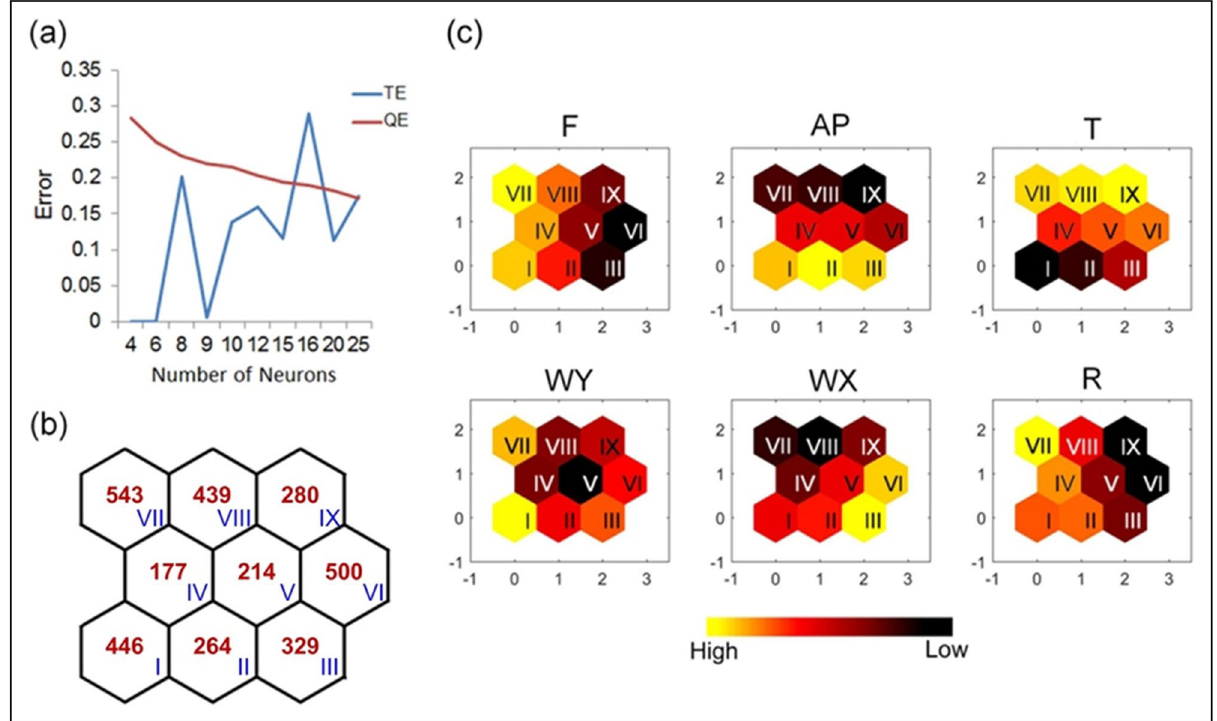
Figure 2. ( a ) Map size was determined to be 9 neurons (i.e., 3×3) based on the measurement of quantization error (QE) and topographic error (TE); ( b ) number of input records (shown in red) in each neuron (shown in blue); ( c ) results of the SOM representing associations of meteorological conditions of air pressure (AP), temperature (T), wind speed in N–S direction (WY) and in E–W direction (WX), and precipitation (R), to the reported time of fish kills